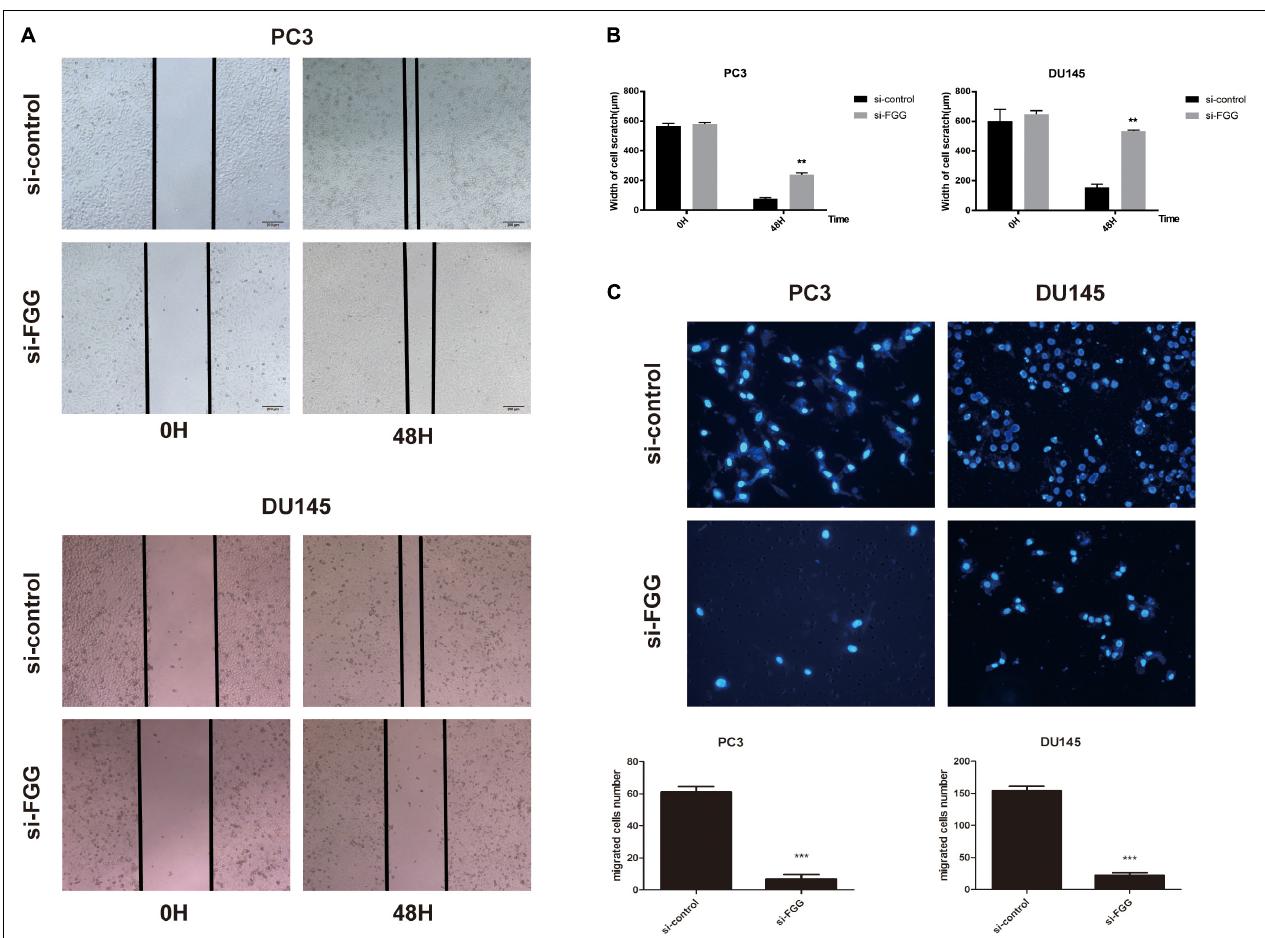
FIGURE 4 | FGG knockdown reduces the migration and invasion capabilities of PCa cells. (A) Wound-healing assays demonstrate that FGG knockdown decreases cell migration in PC3 and DU145 cells compared to control cells. (B) Quantification of the cell scratch. (C) DAPI staining and cell counting from transwell assays indicate that FGG knockdown reduces the invasiveness of PC3 and DU145 cells. ** p < 0.01, *** p <